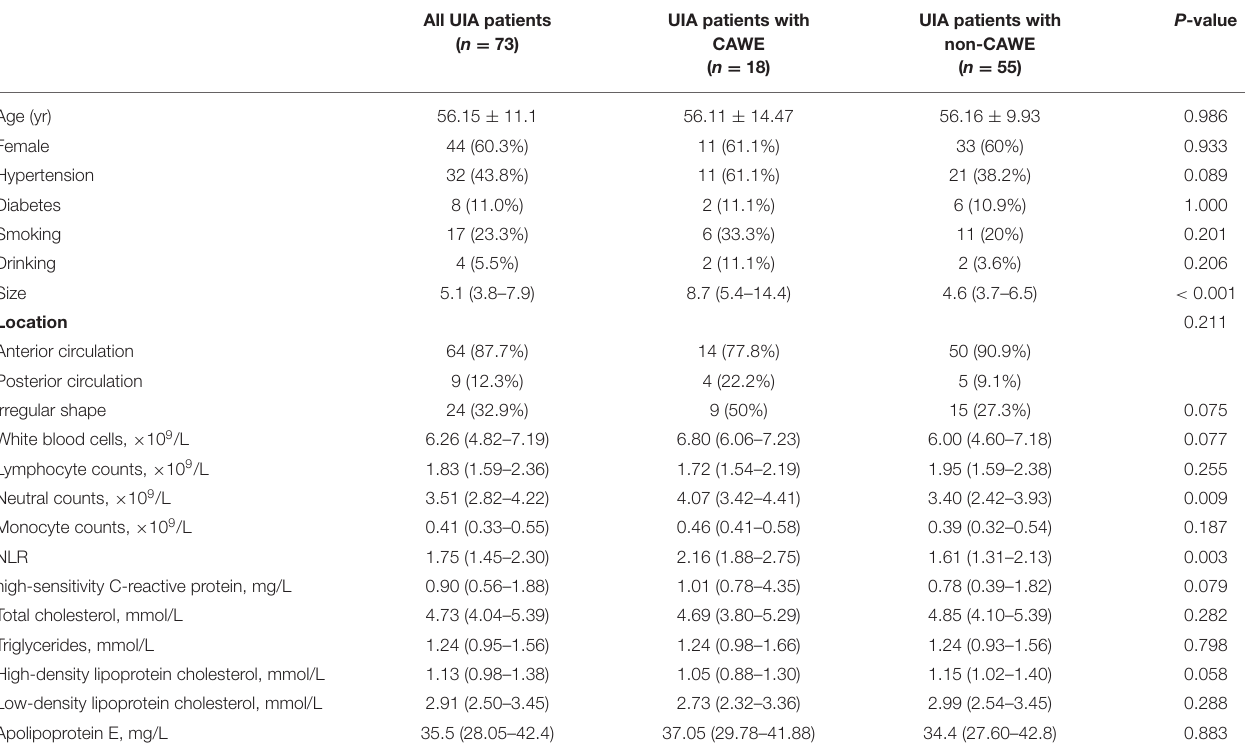
TABLE 2 | Characteristics of unruptured intracranial aneurysms with and without circumferential aneurysm wall enhancement.